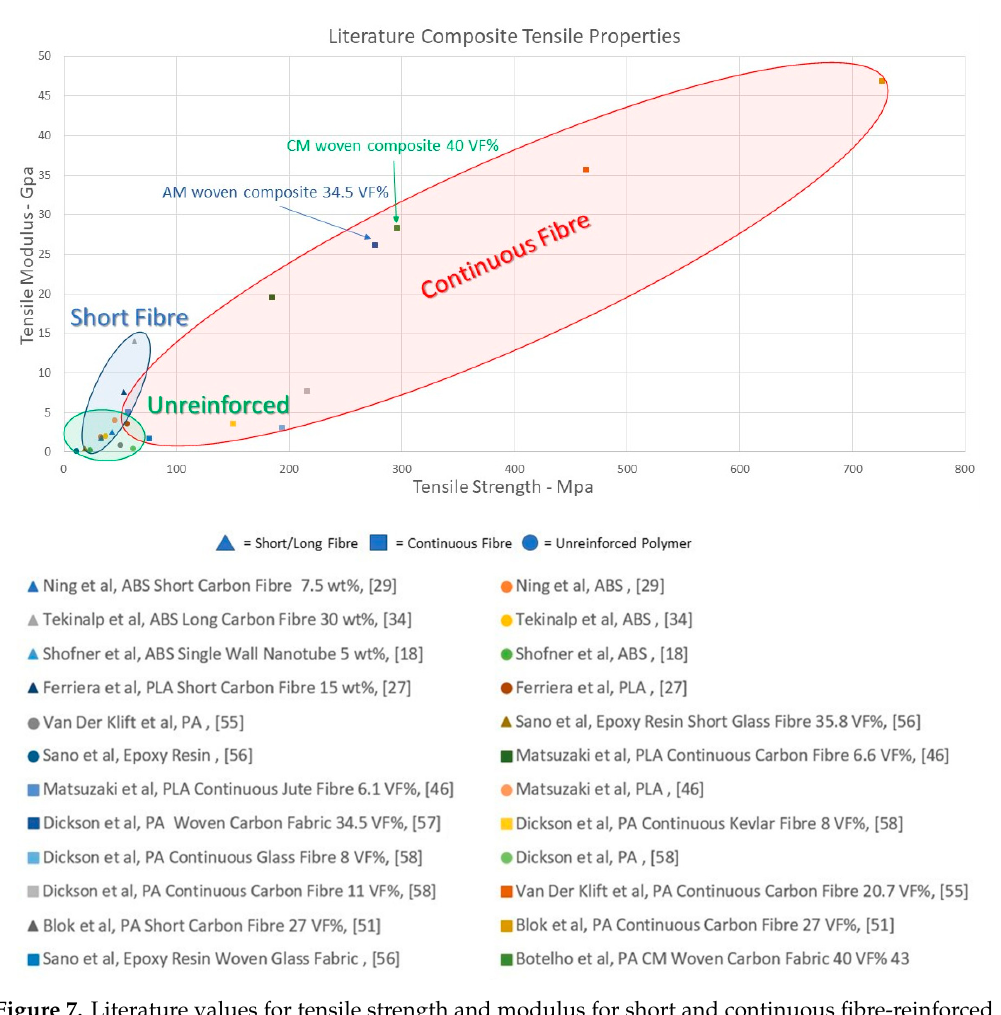
Figure 7. Literature values for tensile strength and modulus for short and continuous fibre-reinforced composites, as well as unreinforced polymers for comparison. A comparison between similar additive manufactured (AM) and compression moulded (CM) woven PA66/CF composites is highlighted, with tensile performance being comparable. Key: Author, matrix, reinforcement, fibre % [18,27,29,34,43,46,51,55–58].